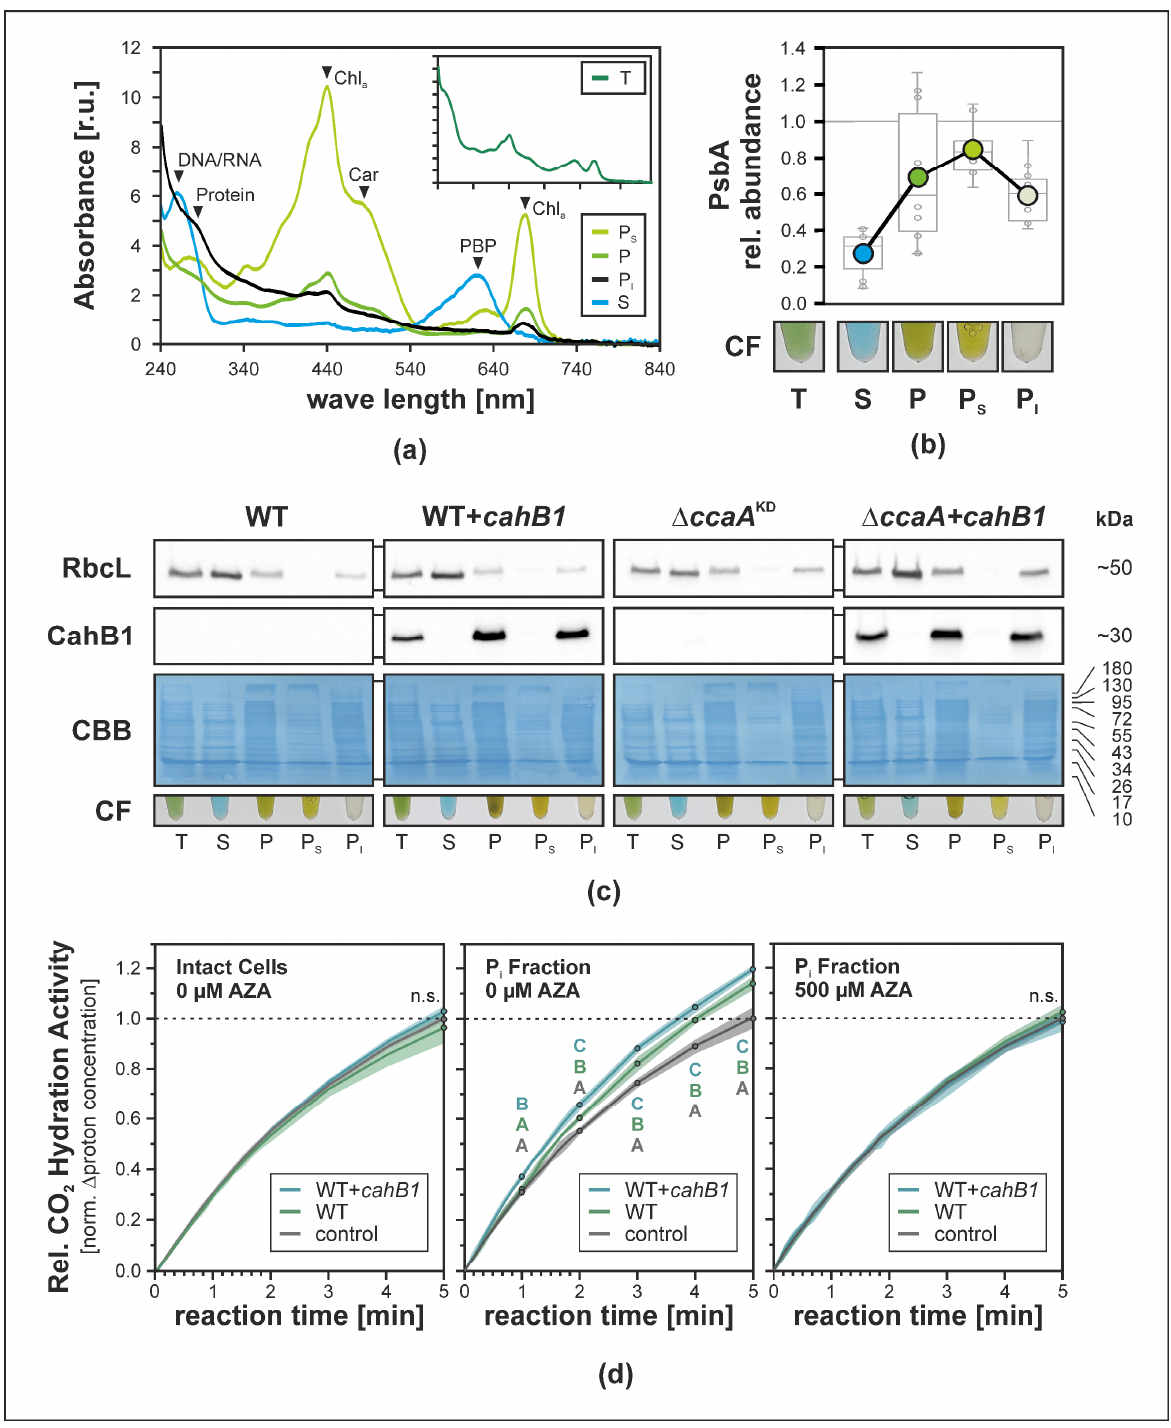
Figure 3. CahB1 localizes to a carboxysome-bearing and CA-active cell fraction in Synechocystis . ( a ) UV/Vis absorbance spectra of Synechocystis cell fractions. Total (T), soluble (S), pelletable (P), and α-/β-DDM solubilizable (P S ) and insolubilizable (P I ) subfractions of P. Traces represent average absorbance spectra adjusted to total protein content for all processed samples ( n = 12; n = 3 for each genotype). Black arrowheads indicate compound correspondences of local absorbance maxima. [r.u.], relative units; Chl a , chlorophyll a ; Car, carotenoids; PBP, phycobiliproteins. ( b ) Relative cell fraction (CF) contents of PsbA (D1) approximated by immunoblot ECL signal quantification. Coloured dots: average signal strength relative to T-fraction signals; boxplots: data points for n = 12 samples. Outliers beyond average ± 1.5-fold standard deviation were excluded from the analysis. Representative samples of obtained CFs are shown. ( c ) Immunoblot analyses of RbcL and CahB1 accumulation in CFs. Sample input equilibrated based on Bradford assay protein content estimates; Coomassie Brilliant Blue (CBB) staining of PVDF membranes provided as loading control. ( d ) Rela- tive CA activity of intact cells (left) and P I cell fractions of WT and WT + cahB1 . P I CA activity was measured in absence (middle) and presence (right) of 500 µM acetazolamide (AZA). Averages (graphs) and standard deviations (shaded areas) of n = 3 biological replicates. Uppercase letters in- dicate statistically significant differences ( p ≤ 0.05) in relative CO 2 hydration rates according to mul- tiple simultaneous comparisons in post hoc Bonferroni–Holm-corrected Tukey HSD tests after sta- tistically significant among-group differences were detected by one-way ANOVA ( d Intact Cells) p = 0.194; ( d P I 0 µM AZA) p = 0.005; ( d P I 500 µM AZA) p = 0.319; n.s., not significant.